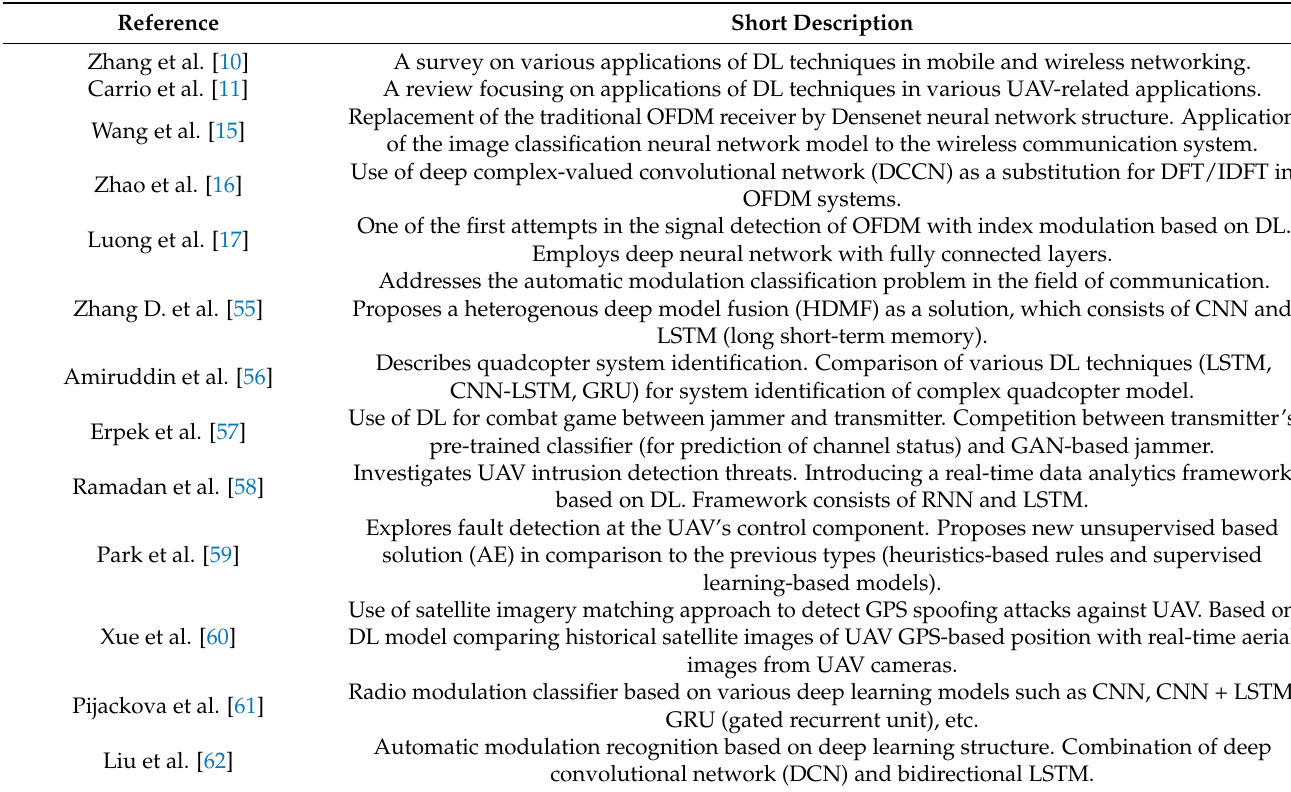
Table 4. Applications of DL algorithms in signal processing and UAV-related